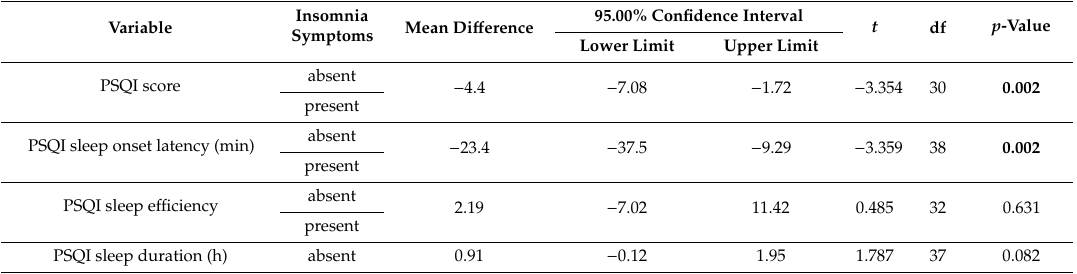
Table 5. Impact of insomnia symptoms on subjective continuous sleep